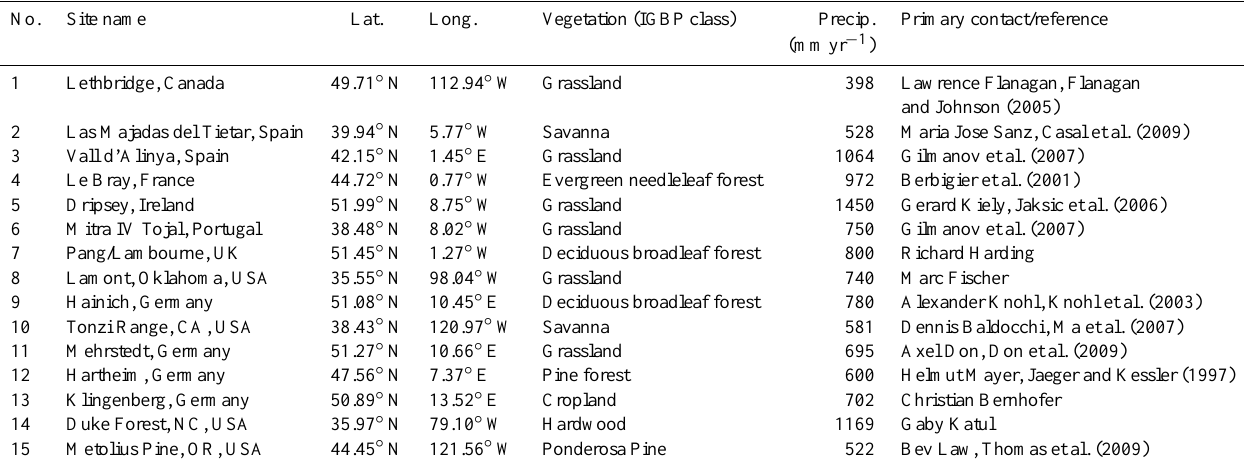
Table 1. Geographical location and characteristics of the 15 FLUXNET study sites as used in the ground validation study.